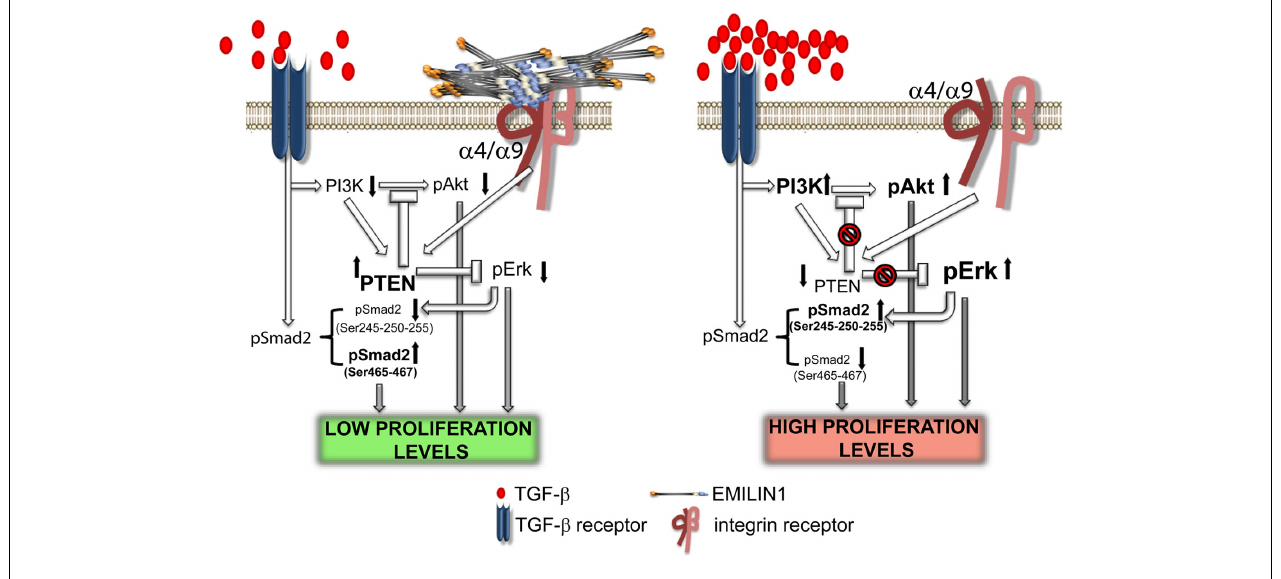
activity of pErk1/2.When EMILIN1 is not present (right) the increased levels of matureTGF- β and the lack of α 4/ α 9 β 1 integrin specific engagement downregulates PTEN determining the activation of the pro-proliferative pAkt and pErk1/2 pathways. In addition,TGF- β signaling is reduced since Erk1/2-phosphorylates the inhibitory Ser245/250/255 residues of